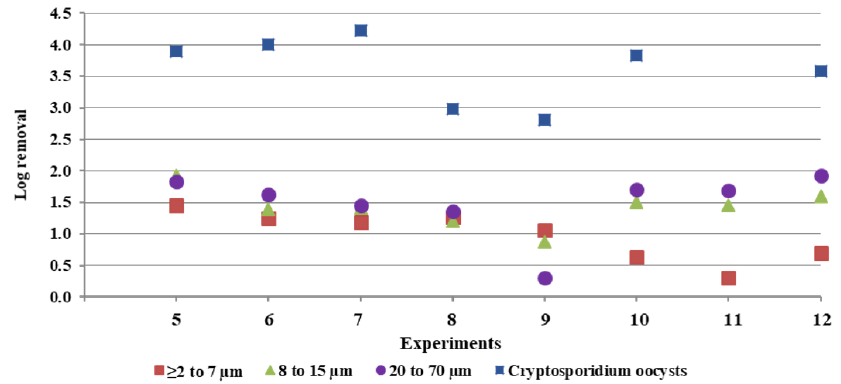
Figure 5. Removal of Cryptosporidium oocysts and particle counts in pilot-scale filtration